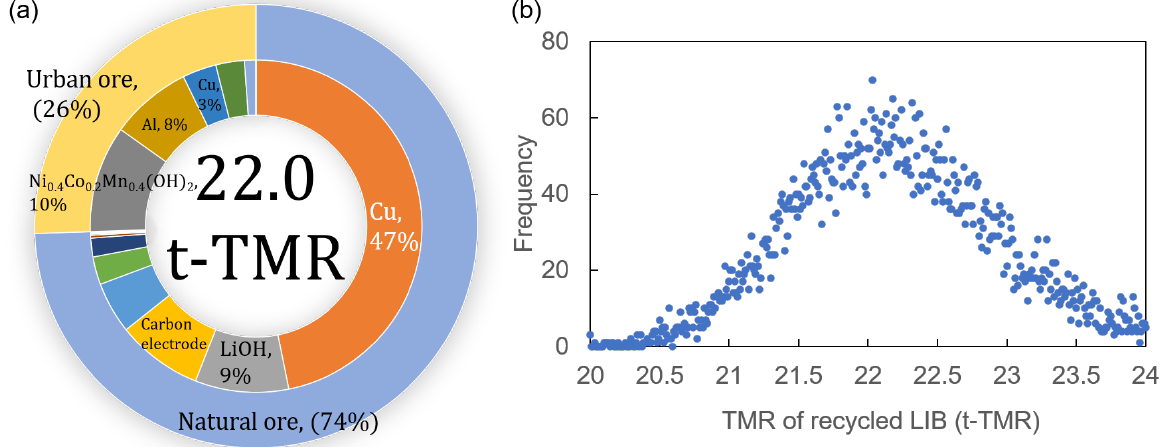
Figure 4. TMR for recycled LIB ( a ) and from the Monte Carlo simulation ( b